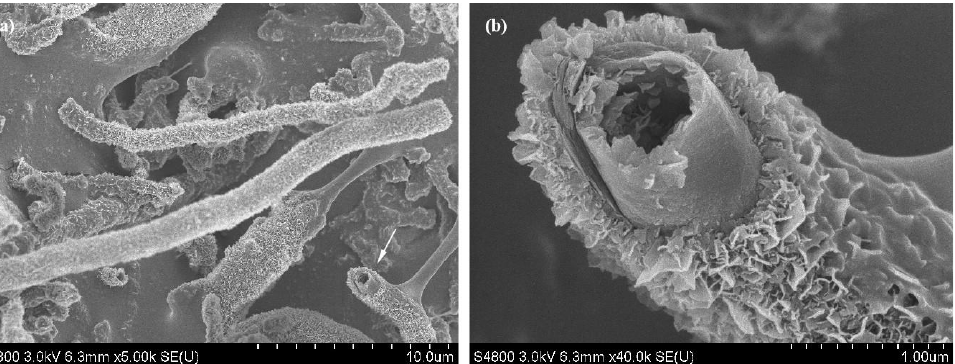
Figure 8. SEM image of the coral-like BN micro-/nanostructure. ( a ) Low-magnification SEM image of the coral-like BN micro-/nanostructure; ( b ) Partial enlarged SEM image of single coral-like BN micro-/nanostructure indicated by an arrow in ( a ).